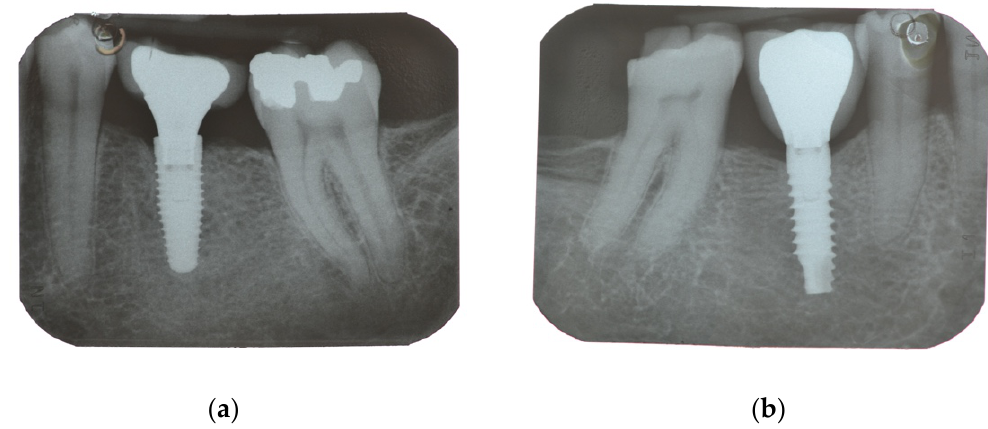
Figure 3. Radiographs after one year. ( a ) Nobel Parallel; ( b ) Prama Sweden & Martina.